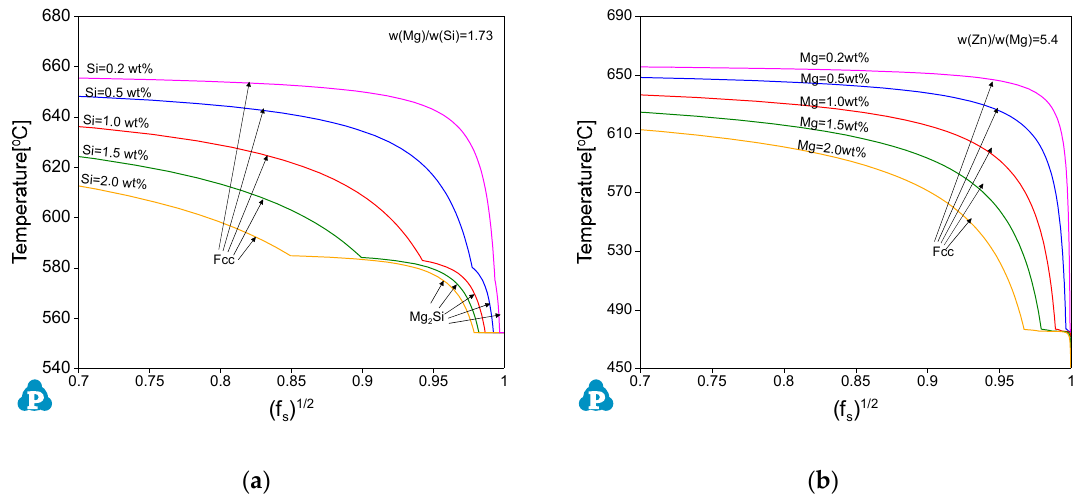
Figure 10. Solidification paths T vs ( f s ) 1/2 by Scheil model for ( a ) Al-Mg-Si alloys along w ( Mg ) / w ( Si ) = 1.73 and ( b ) Al-Mg-Zn alloys along w ( Zn ) / w ( Mg ) =